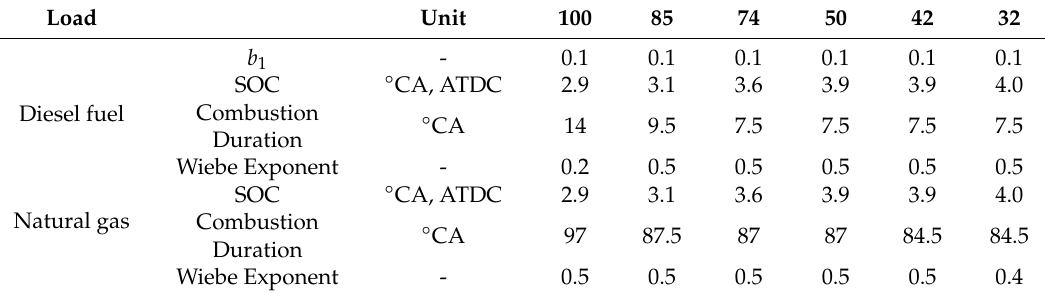
Table 6. Wiebe parameters for the combustion model of Engine B.